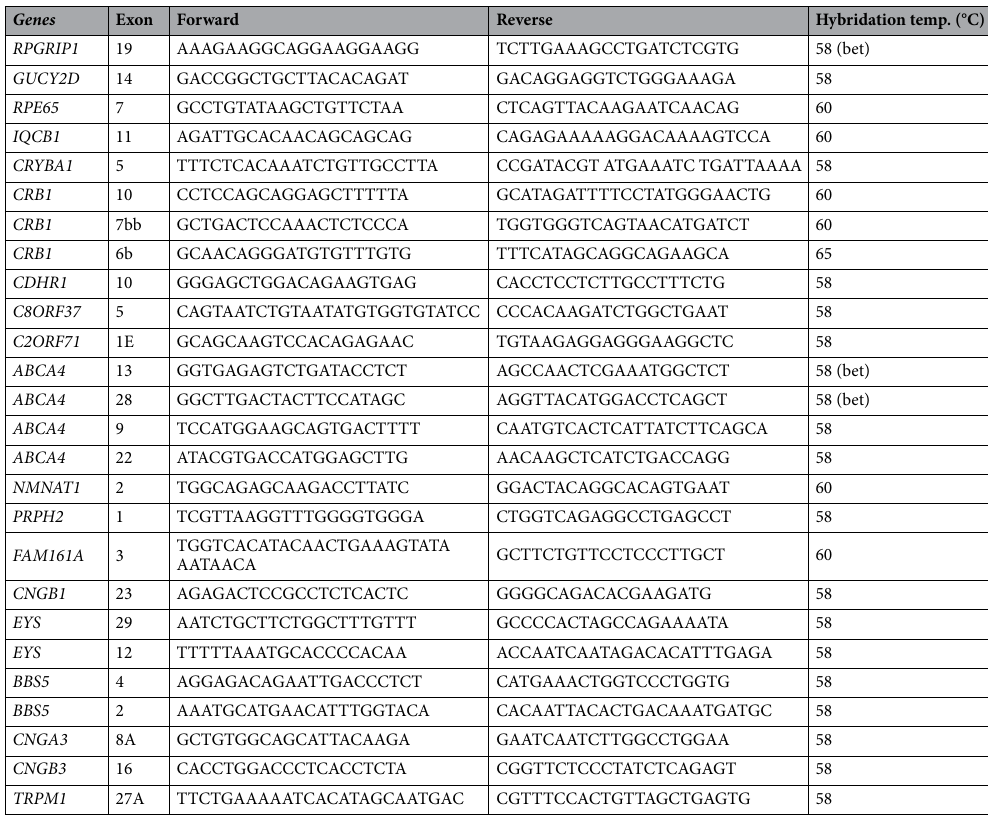
Table 4. Sequences of primers and PCR